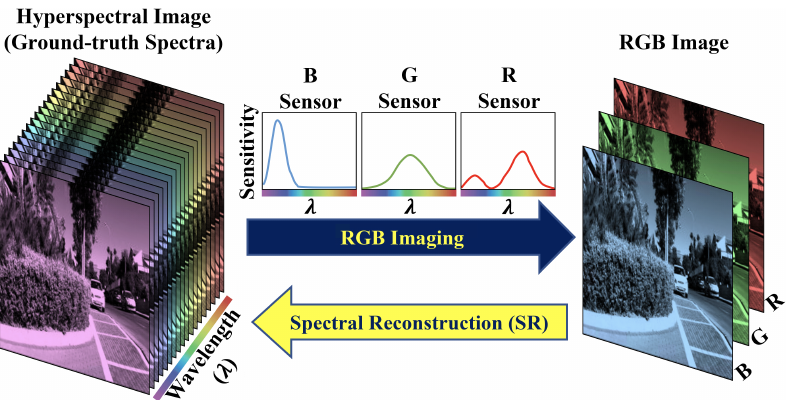
Figure 1. The RGB sensing coarsely sums the spectral intensities into 3 values per pixel. Conversely, spectral reconstruction recovers the lost spectral information from the RGB